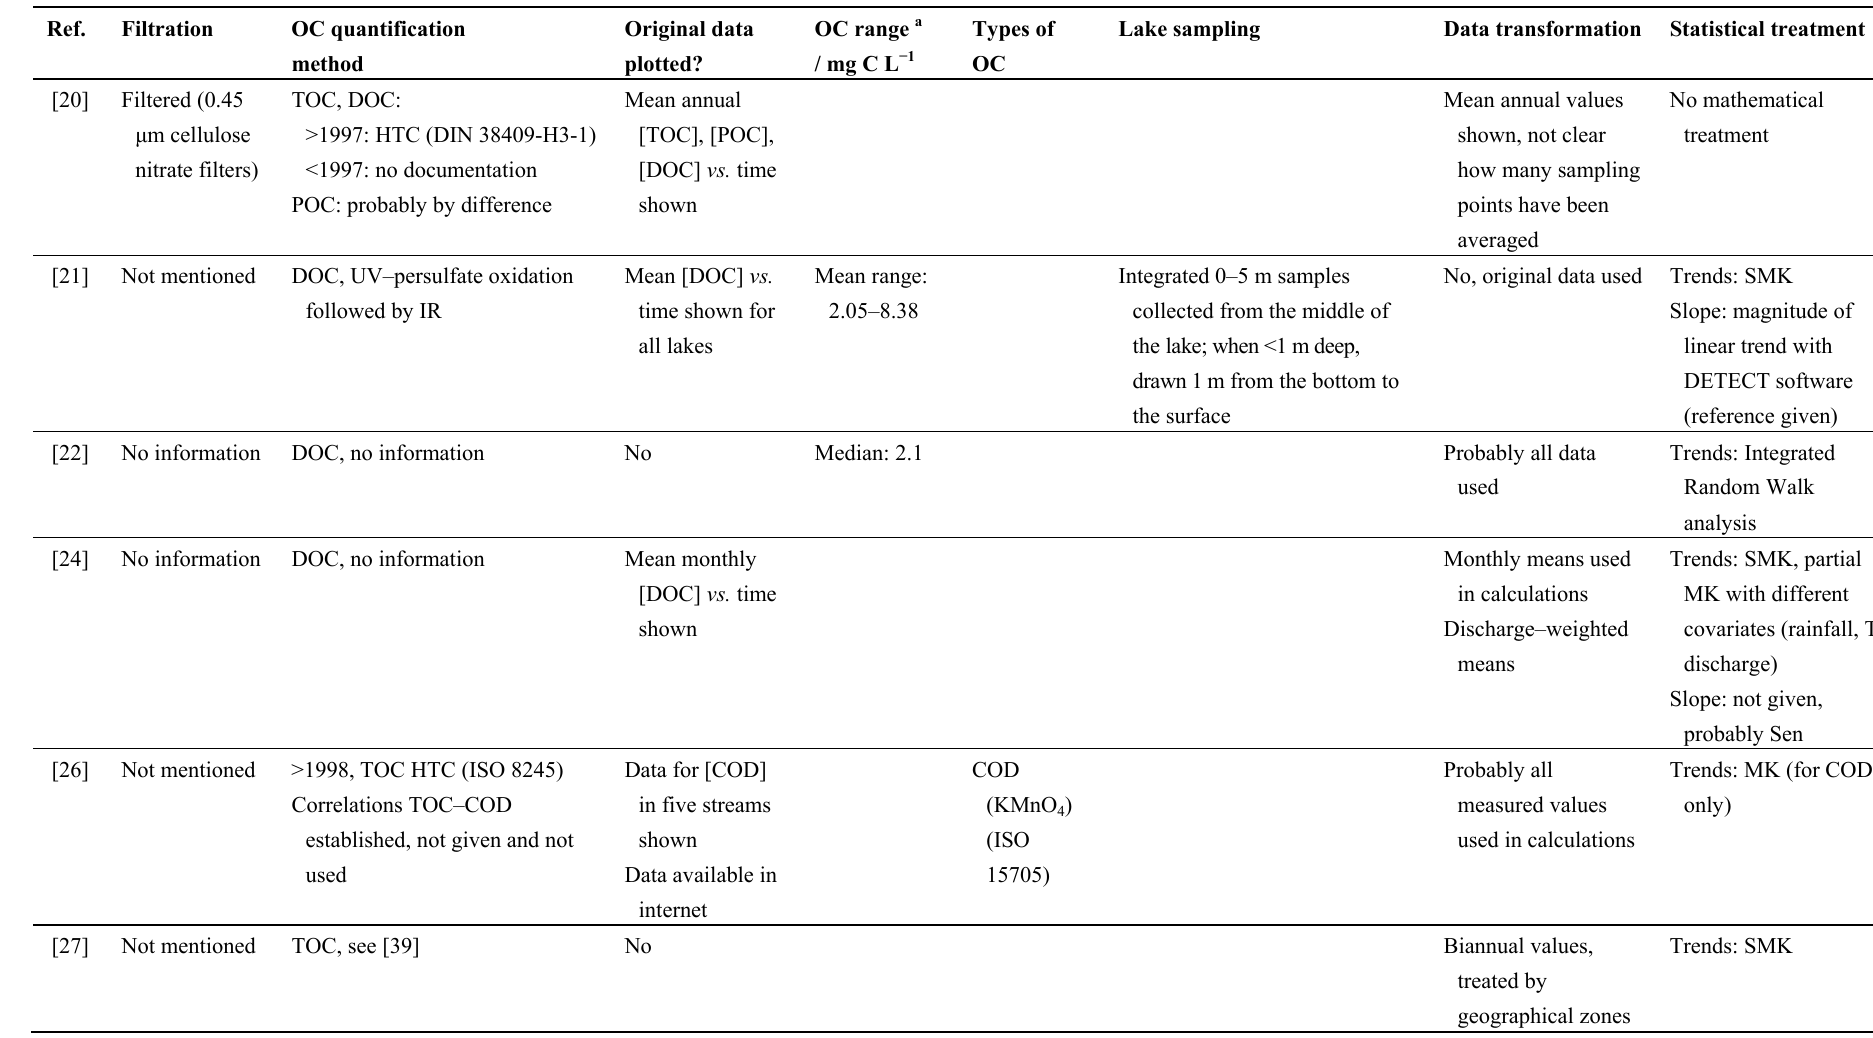
Table 2. Published studies containing long-term organic carbon concentration temporal trends in freshwaters. Methodological information.